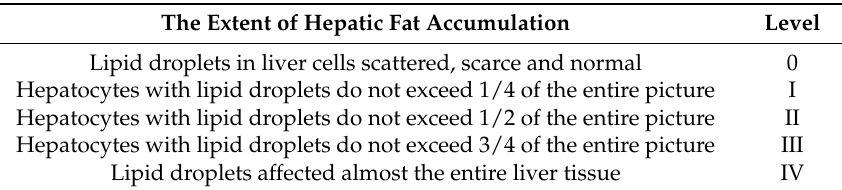
Table 2. The scoring criteria of hepatic steatosis.